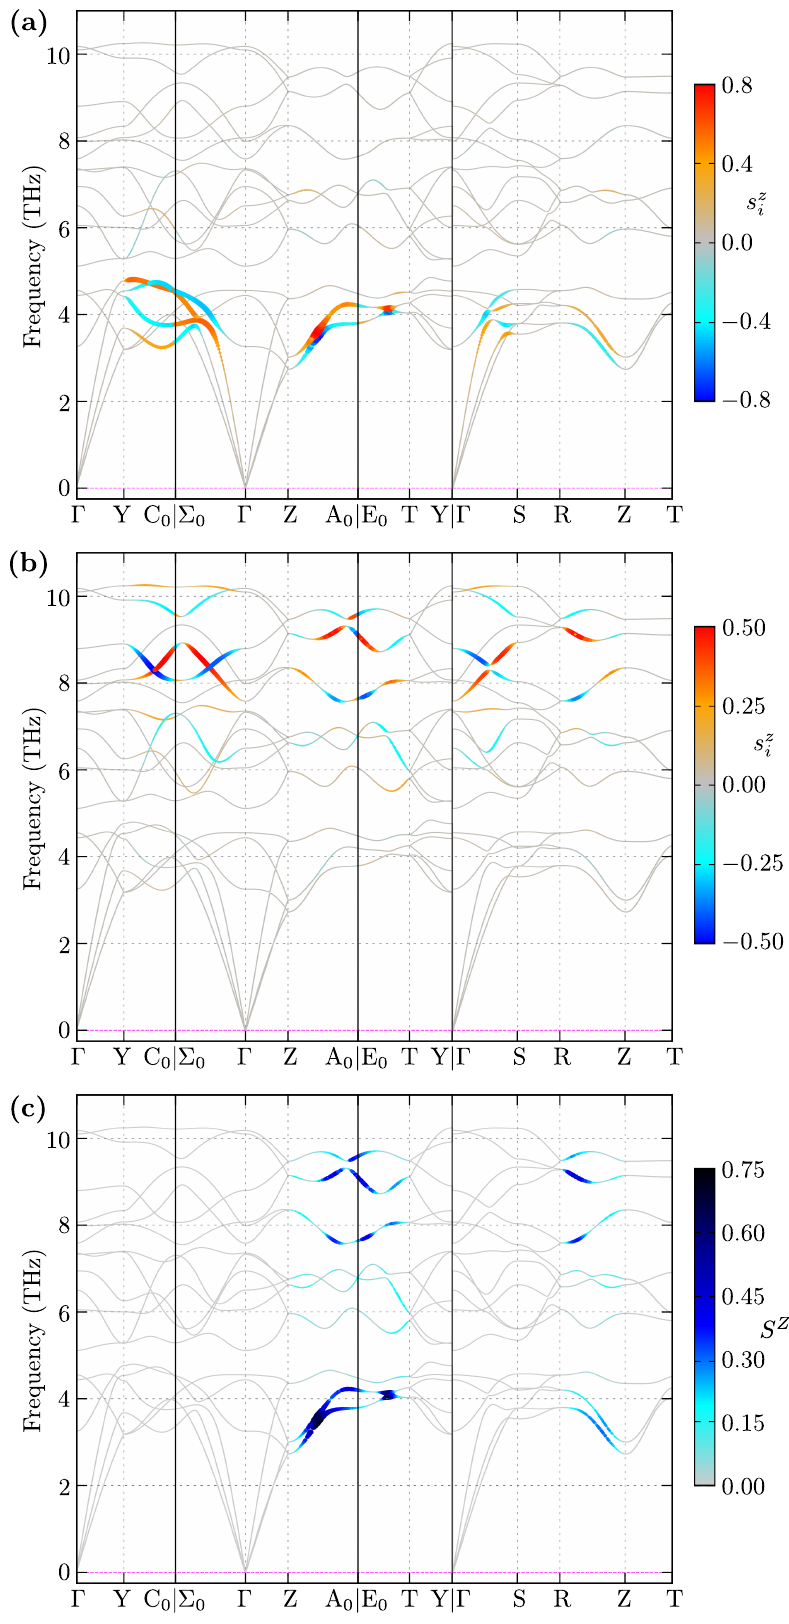
Figure 4. Phonon ciruclar polarization for ( a ) Y and ( b ) Si atoms. Panel ( c ) presents total phonon circular polarization of YAlSi with orthorhombic Cmcm